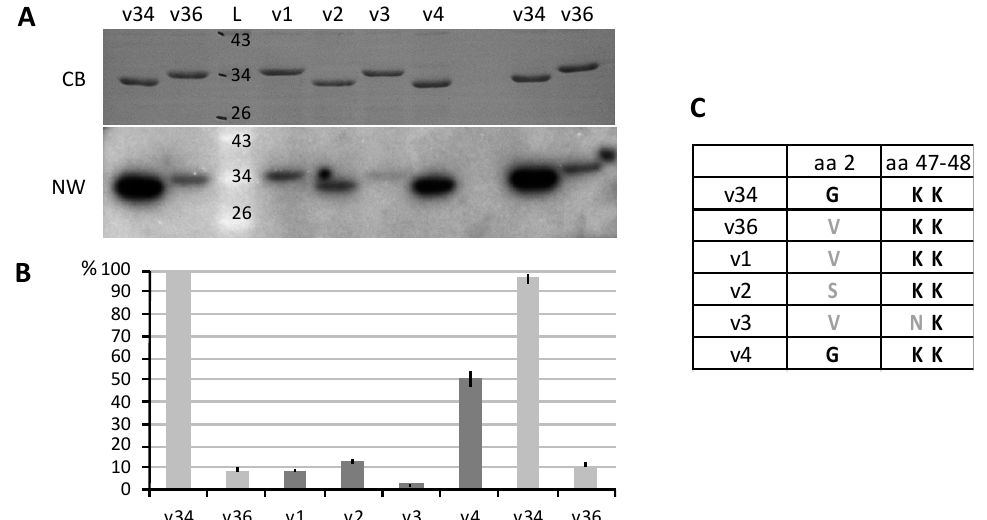
Figure 1. Voltage-dependent anion channel (VDAC) proteins di ff erentially interact with tRNAs in vitro. The six VDAC proteins, potato VDAC34 and VDAC36 (v34, v36) and Arabidopsis VDAC1–4 (v1, v2, v3 and v4) were overexpressed with a His tag in Escherichia coli and purified. The purified proteins were separated on SDS / PAGE and transferred onto membranes. ( A ) Northwestern (NW) blots with radioactive tRNA Ala transcripts. CB, Coomassie blue staining of the membrane; L, ladder (in kDa). ( B ) Quantification. Three similar blots were hybridized with tRNA transcripts. The signals were quantified and normalized on the first v34 loading, and means were calculated. ( C ) Amino acids in positions 2, 47 and 48. Gly 2 and K 47 K 48 have been shown to be involved in tRNA interaction [10]. Error bars, standard error of the mean (SEM).